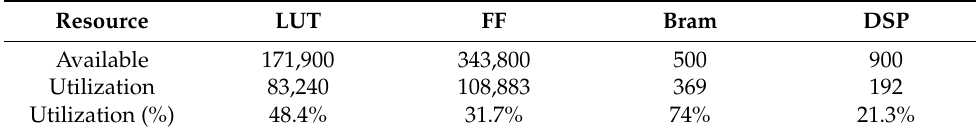
Table 2. The hardware resource utilization of the